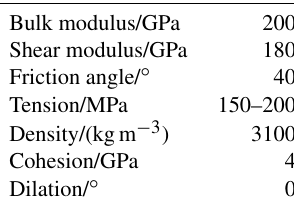
Table 3. Constitutive parameters for matrix.